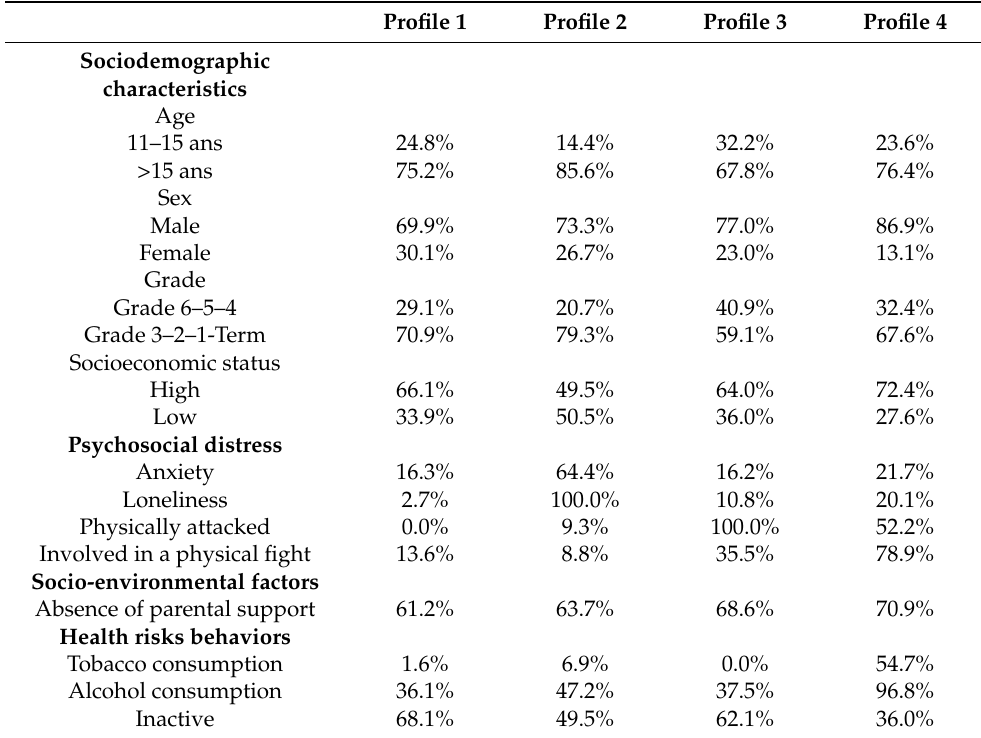
Table 5. Characteristics of profiles obtained among adolescents aged 11–18 in Benin,